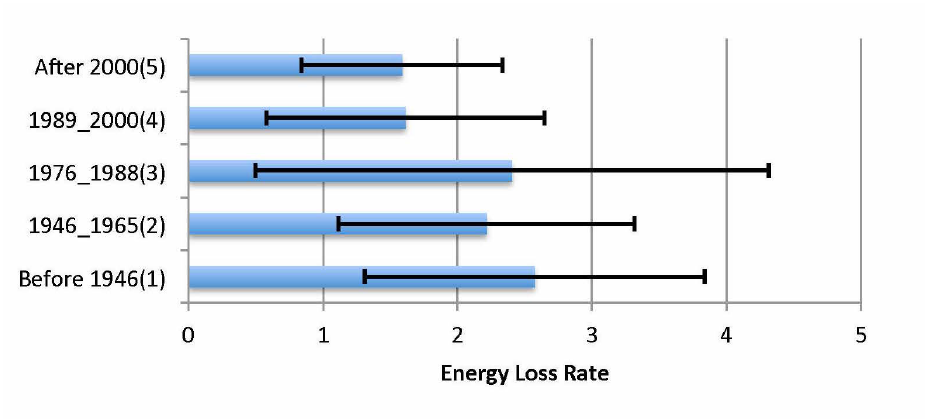
Figure 8. Relation between building year of the house and estimated value for heat loss rate.